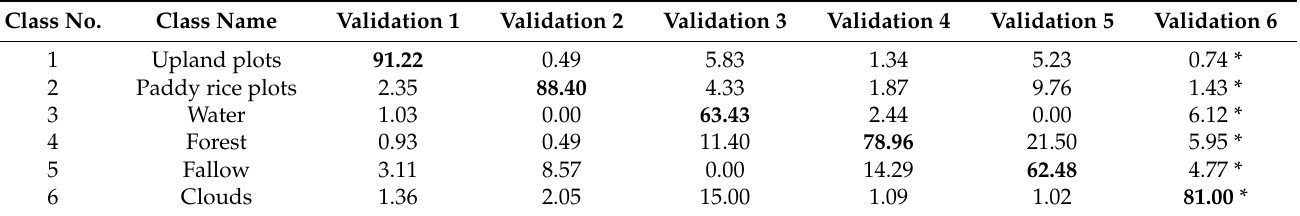
Table 3. RF image classification average accuracy matrix for the full